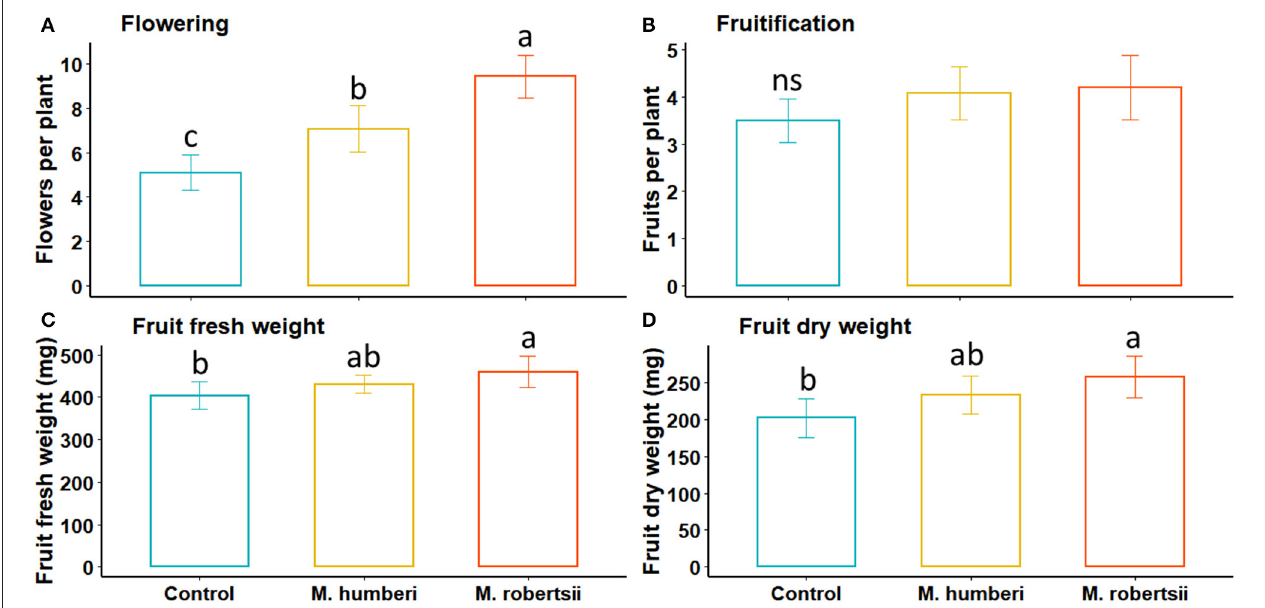
FIGURE 2 | Reproductive growth traits ( A - Flowering, B - Fruitification, C - Fruit fresh weight, and D - Fruit dry weight) of Micro-Tom inoculated with M. robertsii or M. humberi measured 30 days after inoculation. Vertical bars (mean ± 95% CI [confidence interval], n = 20 replicates) with distinct letters indicate significant differences between fungal species at P < 0.05 (Tukey HSD test). Not significant at P > 0.05 (ns).